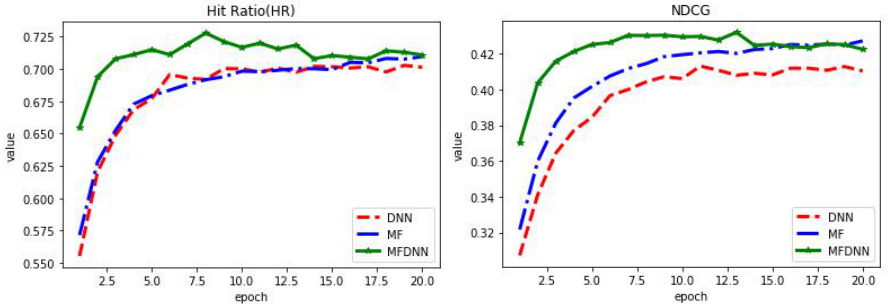
Figure 11. HR and NDCG values for MF, DNN, and MFDNN.